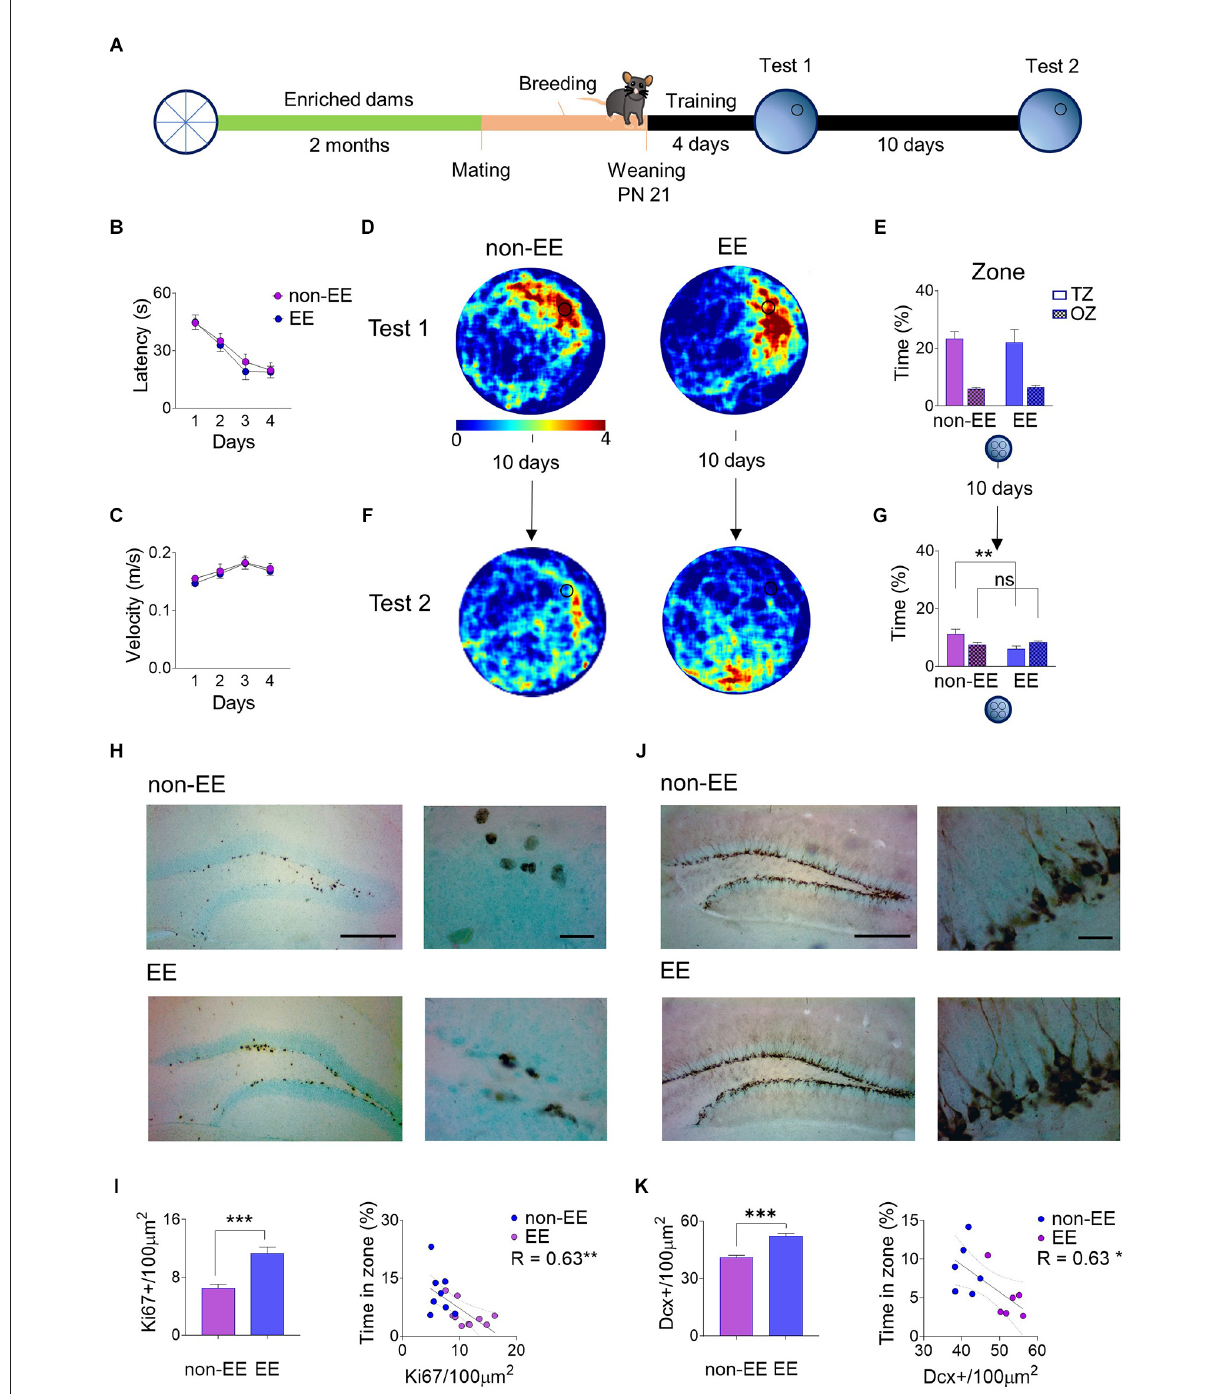
FIGURE1 Female mice were exposed to an enriched environment for 2 months; after that, they were mated with males and allowed to breed. P21 pups were trained in the water maze, given one probe test and a second retention probe test after 10 days. (A) Control mice of the same age (non-EE) and the offspring of enriched dams (EE) learned at the same rates during training (B) and showed the same swimming speed (C) . At the first probe test, non-EE and EE mice swam the same times around the former platform location, showing both heatmaps (the stronger color depicts up to four crosses in the area) (D) and the time spent in the correct zone vs. other zones (E) . However, 10 days later, there was a reduction in the time spent around the original platform site in both groups. Nevertheless, the heatmaps showed a notoriously higher reduction in the EE group (F) . The time spent in the correct zone vs. other zones decreases more in the EE group than in the control group (G) . The proliferation marker